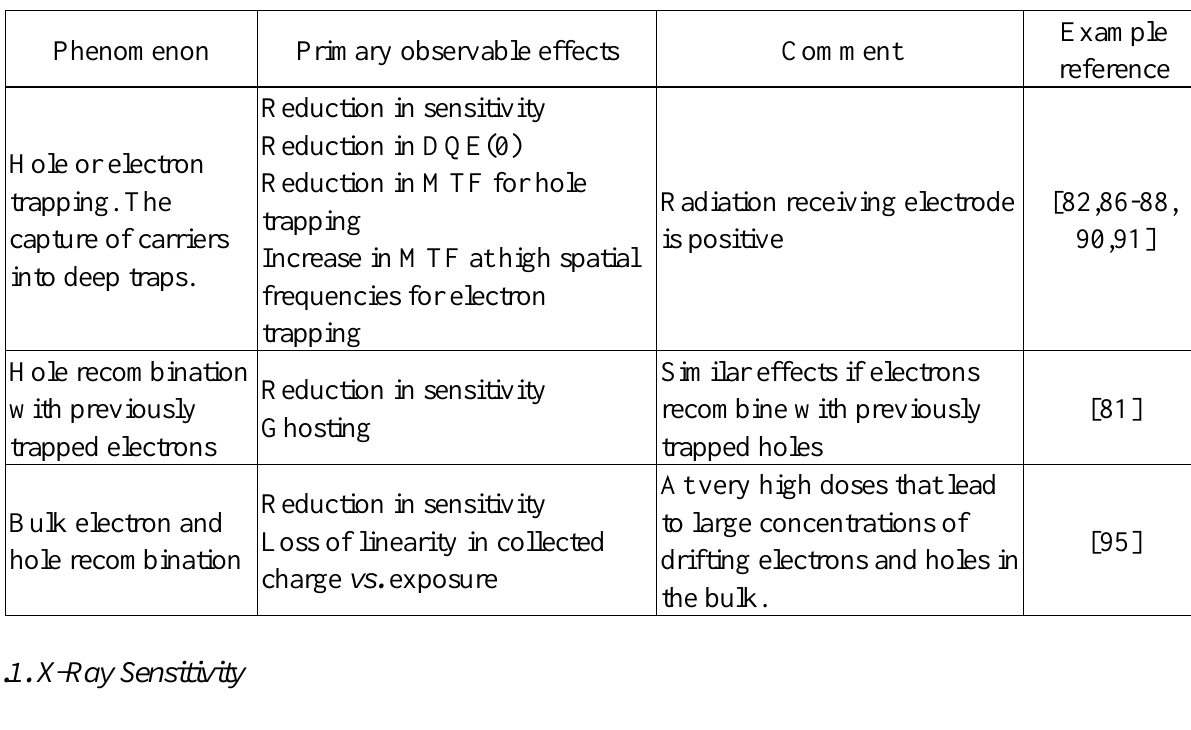
Table 2. Effects of charge carrier trapping in the x-ray photoconductor layer (e.g., a-Se) on various image sensor metrics. We assume that the radiation receiving electrode is positively biased and the negative electrode is pixellated. Reversal of the biasing potential results in identical effects for the opposite